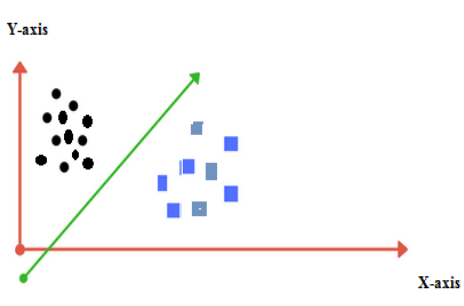
Figure 6. Separation in less complex data